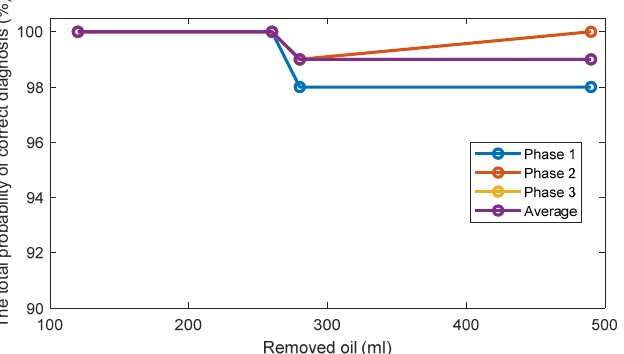
Figure 4. The TPOCD, provided by technology 1 (based on the first harmonic of the supply frequency) for three phases and 4 levels of oil removal compared to the standard oil level (Day 1).